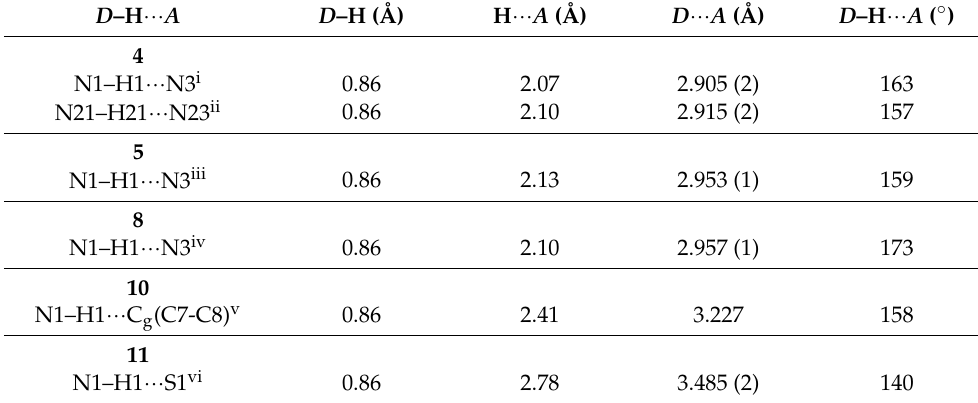
Table 2. Hydrogen bond parameters.